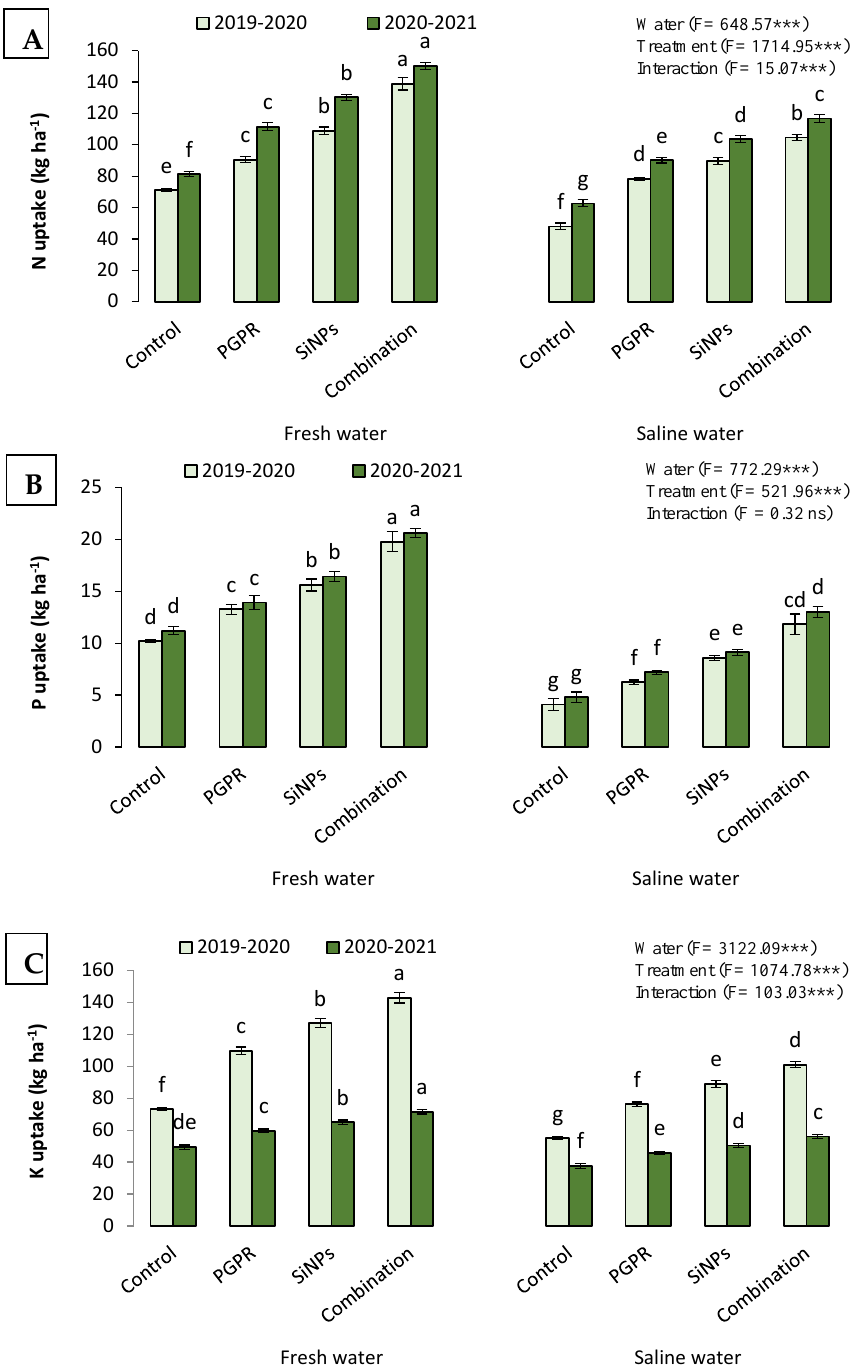
Figure 3. Variations of the uptake of: ( A ) N; ( B ) P; and ( C ) K by barley ( Hordum vulgare L., cv. Giza 132), which was cultivated in salt-affected soil and treated with plant growth-promoting rhizobacteria (PGPR; Azotobacter chroococcum SARS 10 and Pseudomonas koreensis MG209738), silica nanoparticles (SiNPs), and their combination to alleviate the detrimental impacts of saline irrigation water during two consecutive seasons. Different letters in the same columns of the same season are significant according to the Tukey’s test ( p ≤ 0.05). Two-way ANOVA was run to display the significant differences between types of irrigation water, treatments, and their interaction according to the Tukey’s test ( p ≤ 0.05). Data are the means ± SD and n = 3. *** denotes significance at p ≤ 0.001, ns denotes insignificant difference.